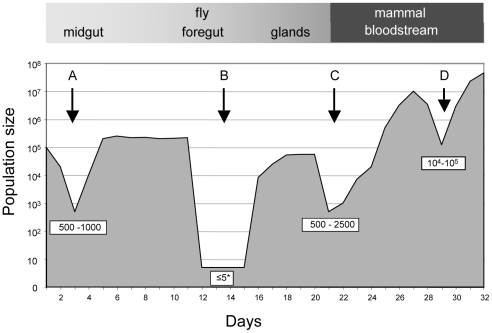
Population size through the life cycle of T. brucei based on data from this study.A: establishment of infection in the fly midgut following a blood meal; B: trypanosomes migrating to the salivary glands; C: establishment of infection in the mammal following fly transmission; D: fluctuations in parasite numbers in the mammalian bloodstream. Numbers in boxes refer to minimum numbers of trypanosomes surviving the transition between different tissues and hosts. The asterisk depicts the possibility that there might be waves of migration of a few parasites at a time from the midgut to the salivary glands.